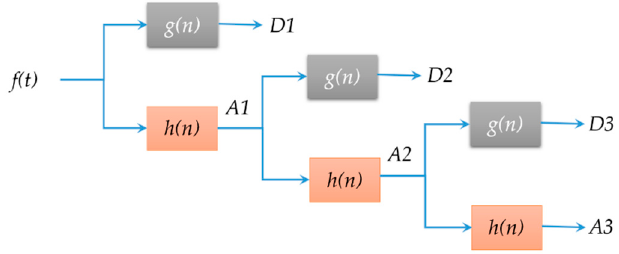
Figure 1. Multiresolution analysis (MRA) decomposition into three scales, where h(n) and g(n) are low-pass and high-pass filters, A approximations and D details.